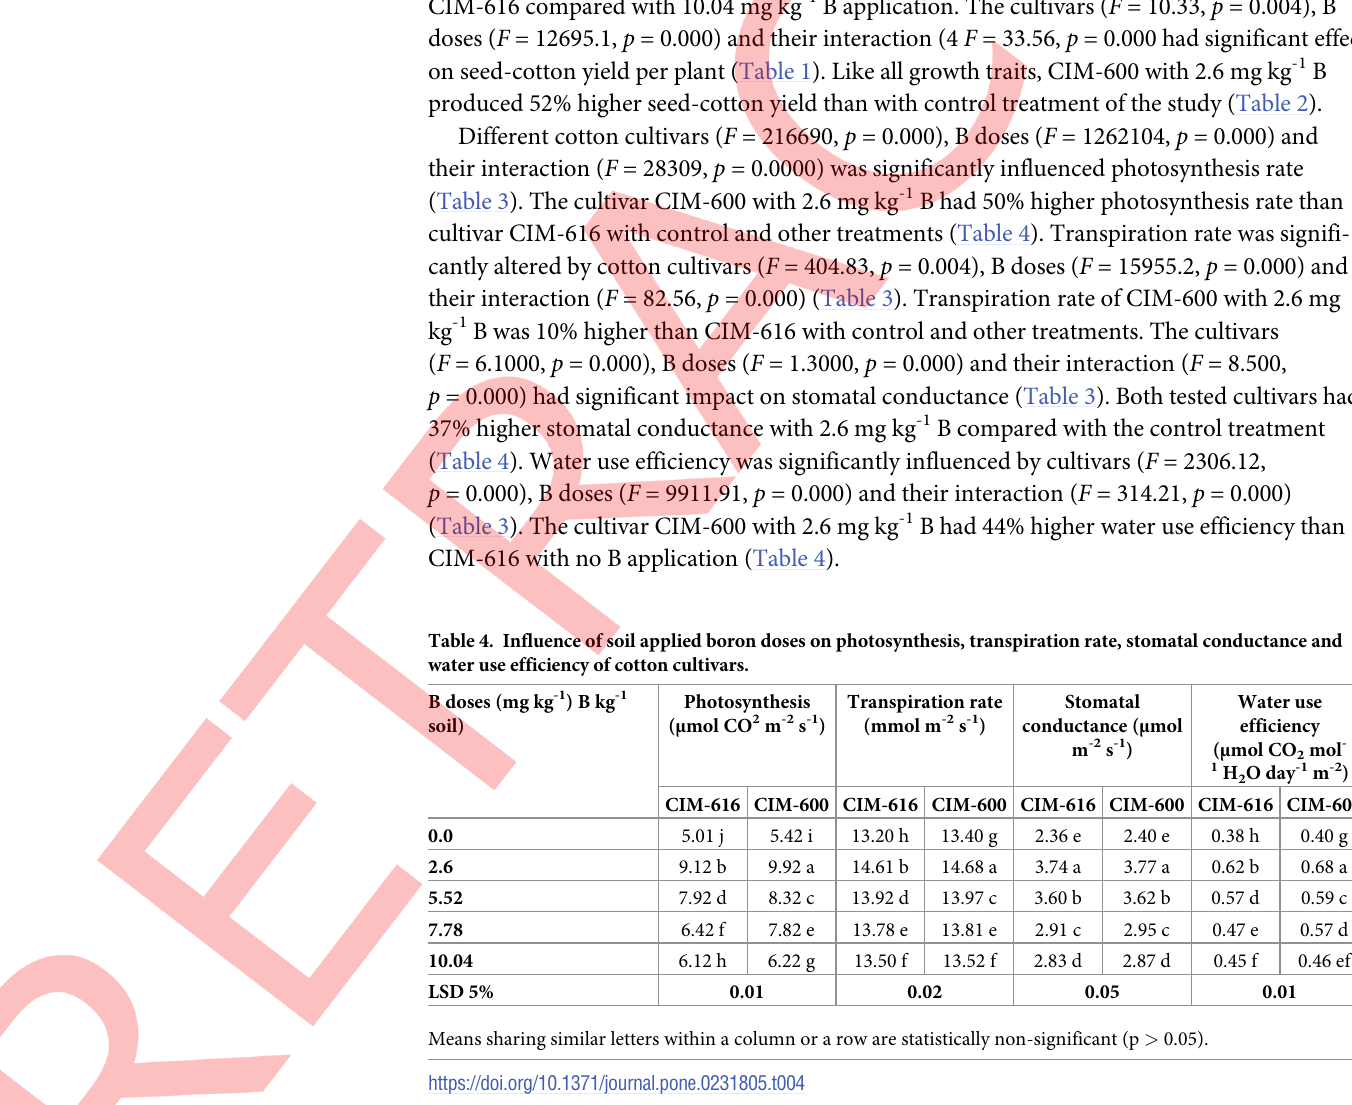
(Table 1). Soil applied 2.6 mg kg -1 B resulted in 52% heavier bolls of cultivars CIM-600 and CIM-616 compared with 10.04 mg kg -1 B application. The cultivars ( F = 10.33, p = 0.004), B doses ( F = 12695.1, p = 0.000) and their interaction (4 F = 33.56, p = 0.000 had significant effect on seed-cotton yield per plant (Table 1). Like all growth traits, CIM-600 with 2.6 mg kg -1 B produced 52% higher seed-cotton yield than with control treatment of the study (Table 2).